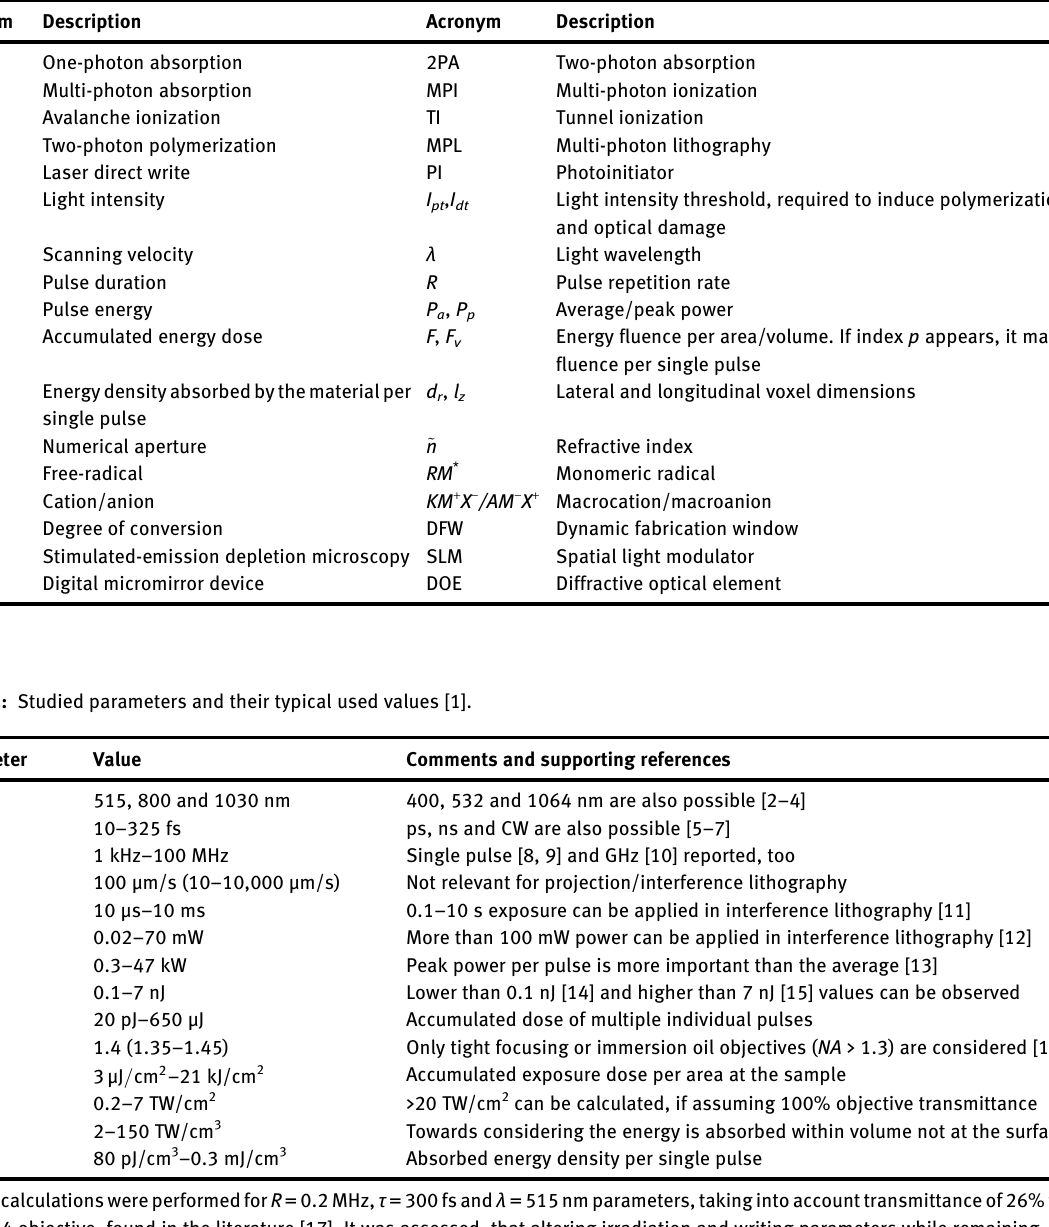
Table  : Acronyms and symbols most commonly used in the text.